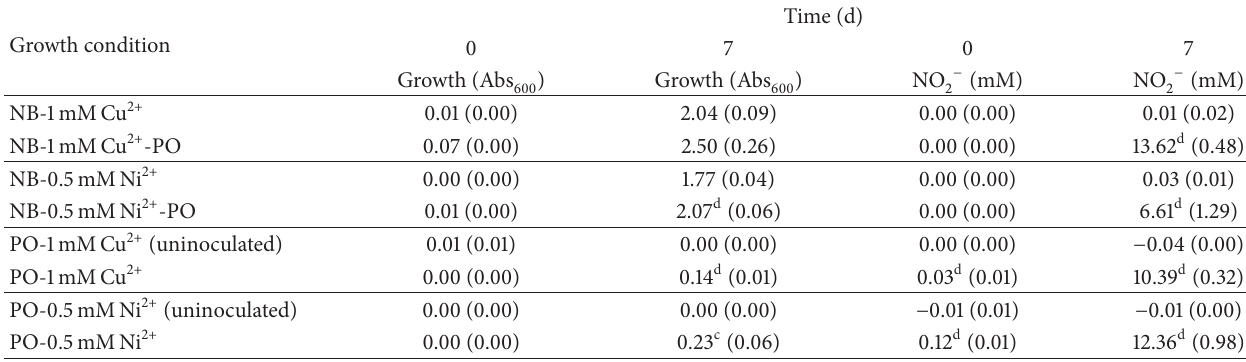
Table 1: Growth and nitrification of PO by C. pauculus UM1 in the presence of either 1mMCu 2+ or 0.5 mMNi 2+ in either NB or PO-mineral salts medium a,b